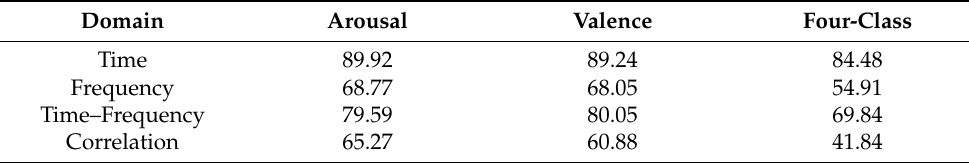
Table 1. Classification accuracies on features from different